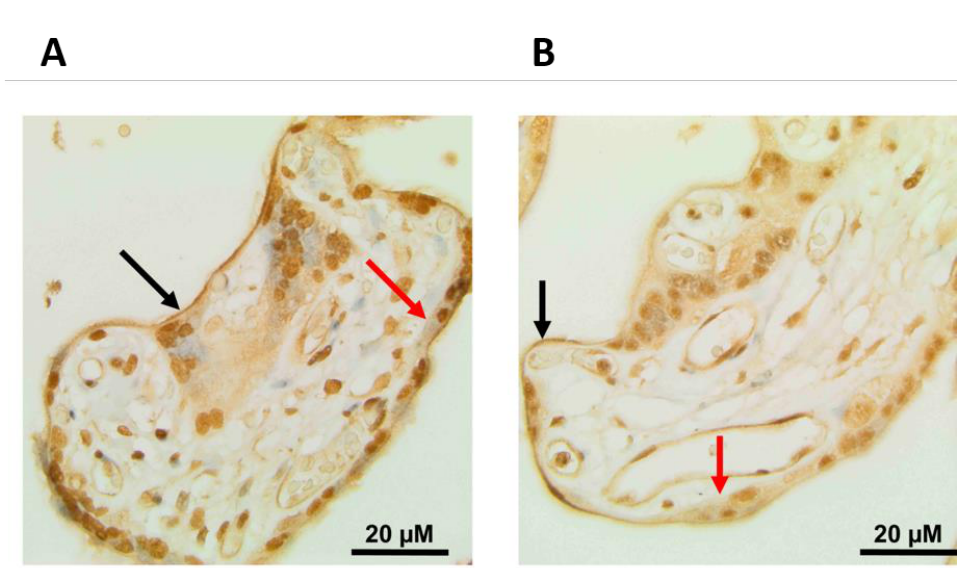
Figure 1. Immunohistological stainings of placental GLUT9a and GLUT9b. The black arrow marks the microvillus (apical) membrane, and the red arrow depicts the basal membrane of the syncytiotrophoblast in placental villi. Scale bar represents 20 µm. ( A ) Staining of a term placenta using anti-GLUT9a antibodies. ( B ) Staining of a term placenta using anti-GLUT9b antibodies. Both antibodies co-localize with the villous (apical) membrane of the syncytiotrophoblast, while no immunohistological signal is detectable in the basal membrane of the syncytiotrophoblast.